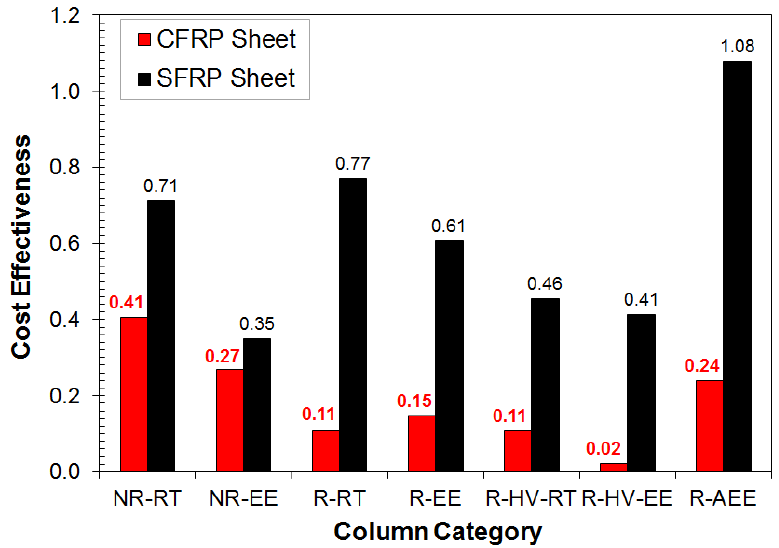
Figure 2. Cost effectiveness of the SFRP and CFRP strengthened concrete